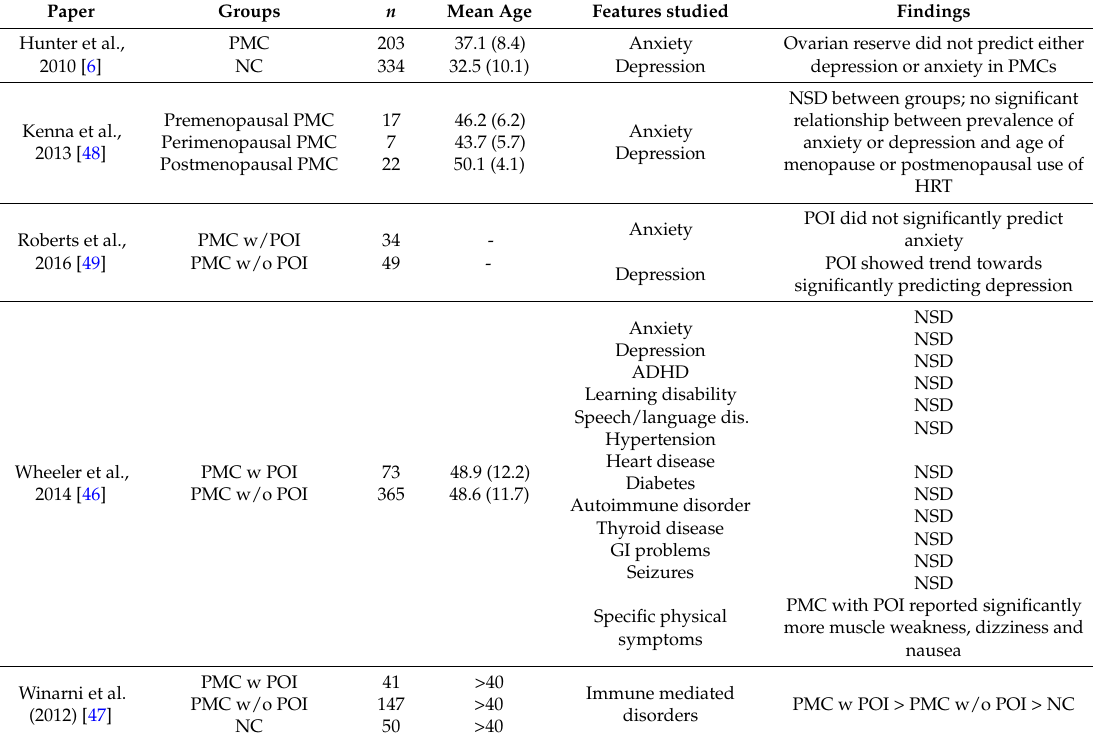
Table 3. Summary of studies considering co-occurring health difficulties in female PMCs with endocrine